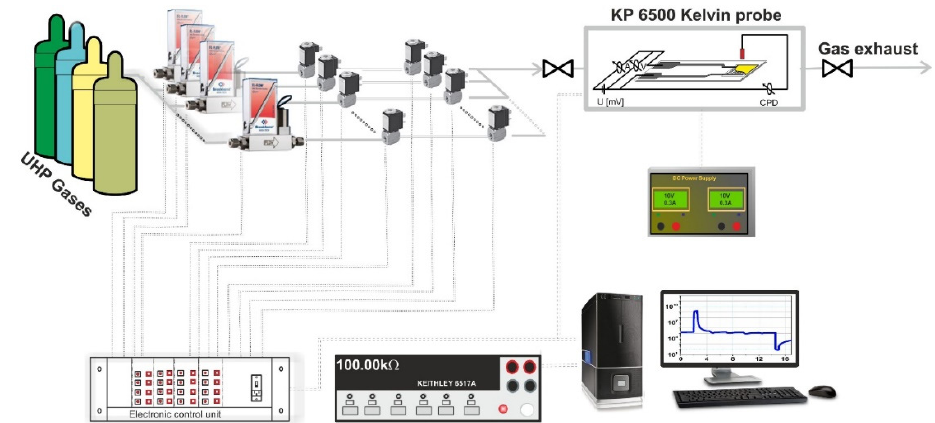
Figure 1. Experimental electrical setup for simultaneous measurements of electrical resistance and contact potential differences.